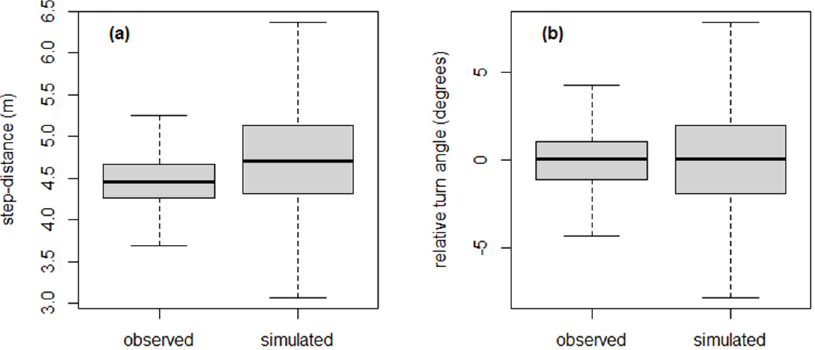
Figure 7. Box and whisker plots of observed and simulated state variables including, step-distance ( a ) and relative turn angles ( b ).